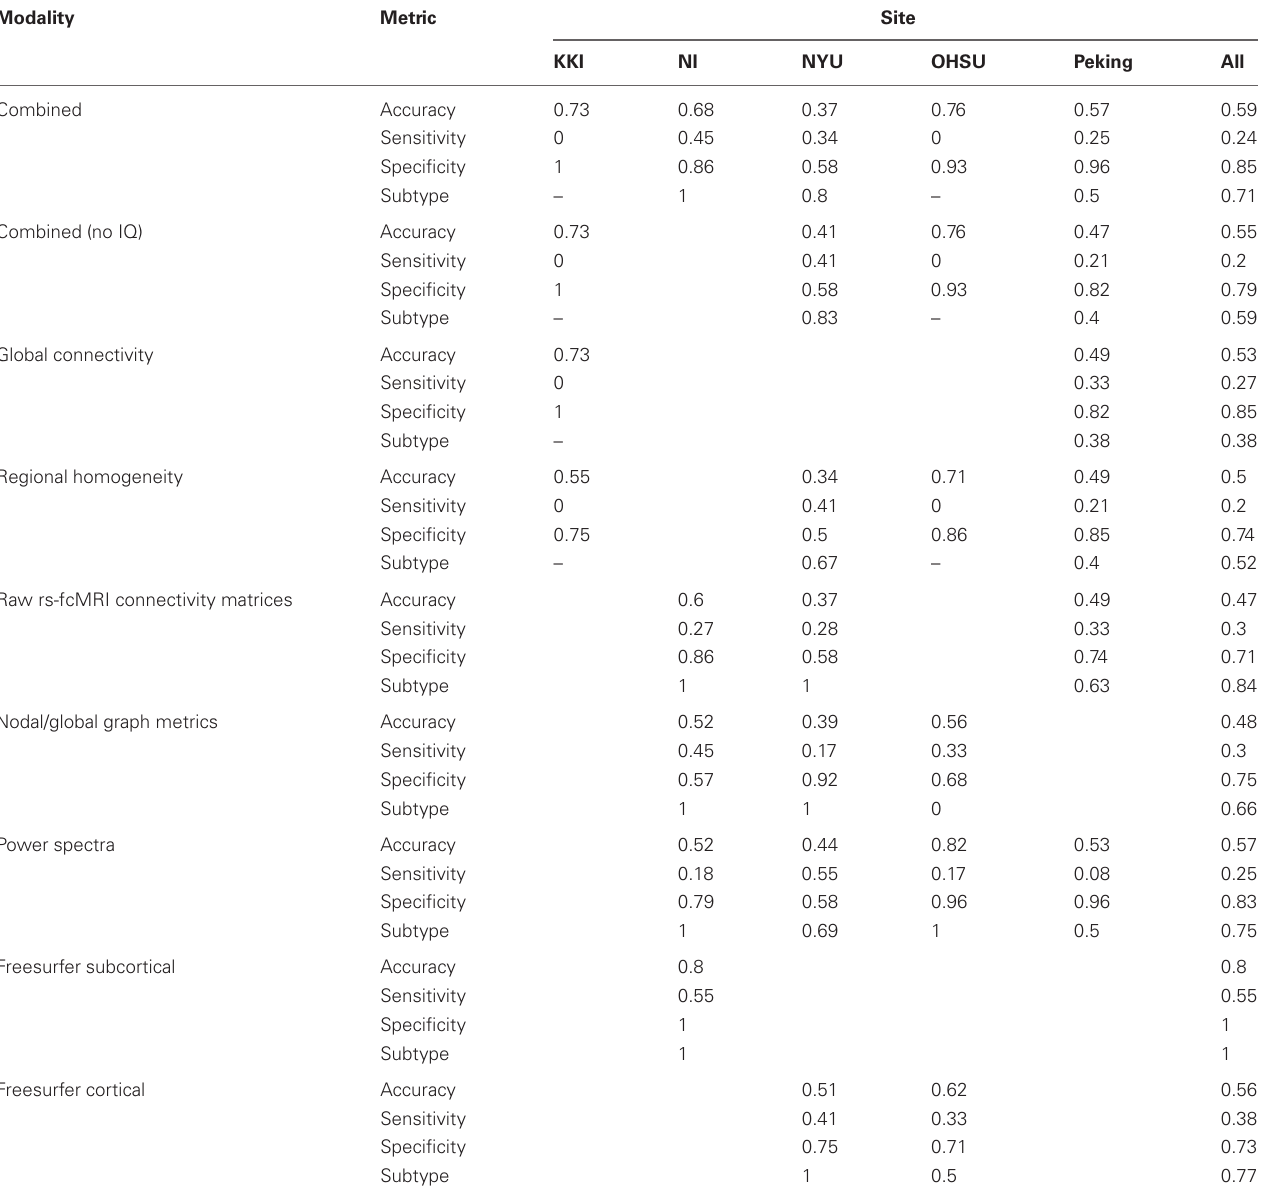
Table 4 | Classifier performance on the test dataset, by site and imaging